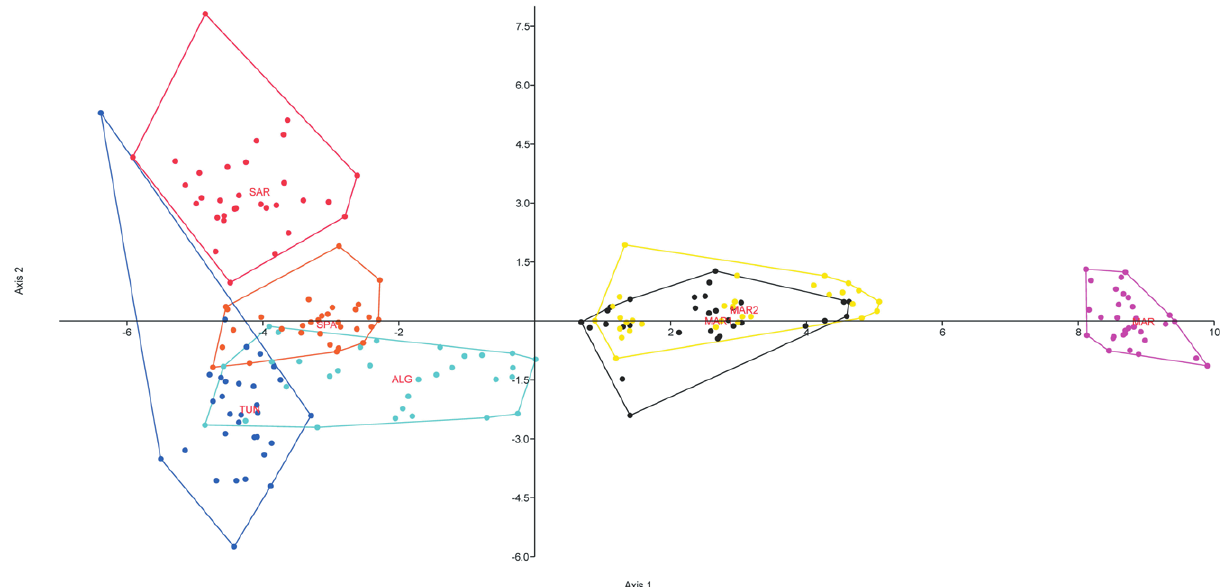
Figure 3. Discriminant analysis based on the 12 considered morphological characters, with 7 a priori defined groups based on the geo- graphical distribution of the sampled populations. Axis 1: Eigenvalue 22.424, % variance 74.11; Axis 2: Eigenvalue 5.635, % variance